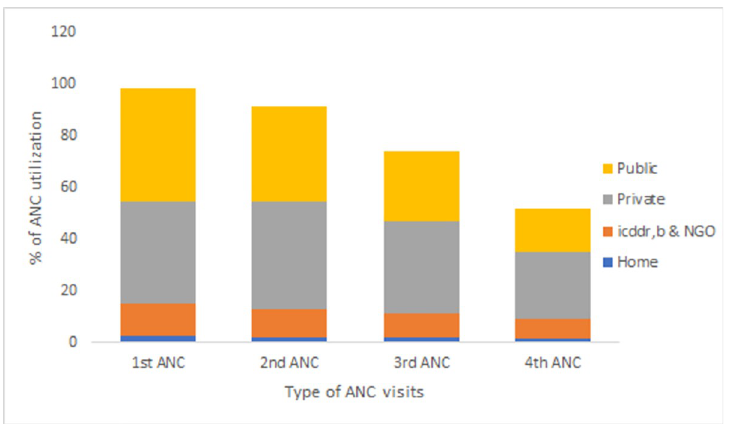
Fig 1. Place of ANC utilization among all